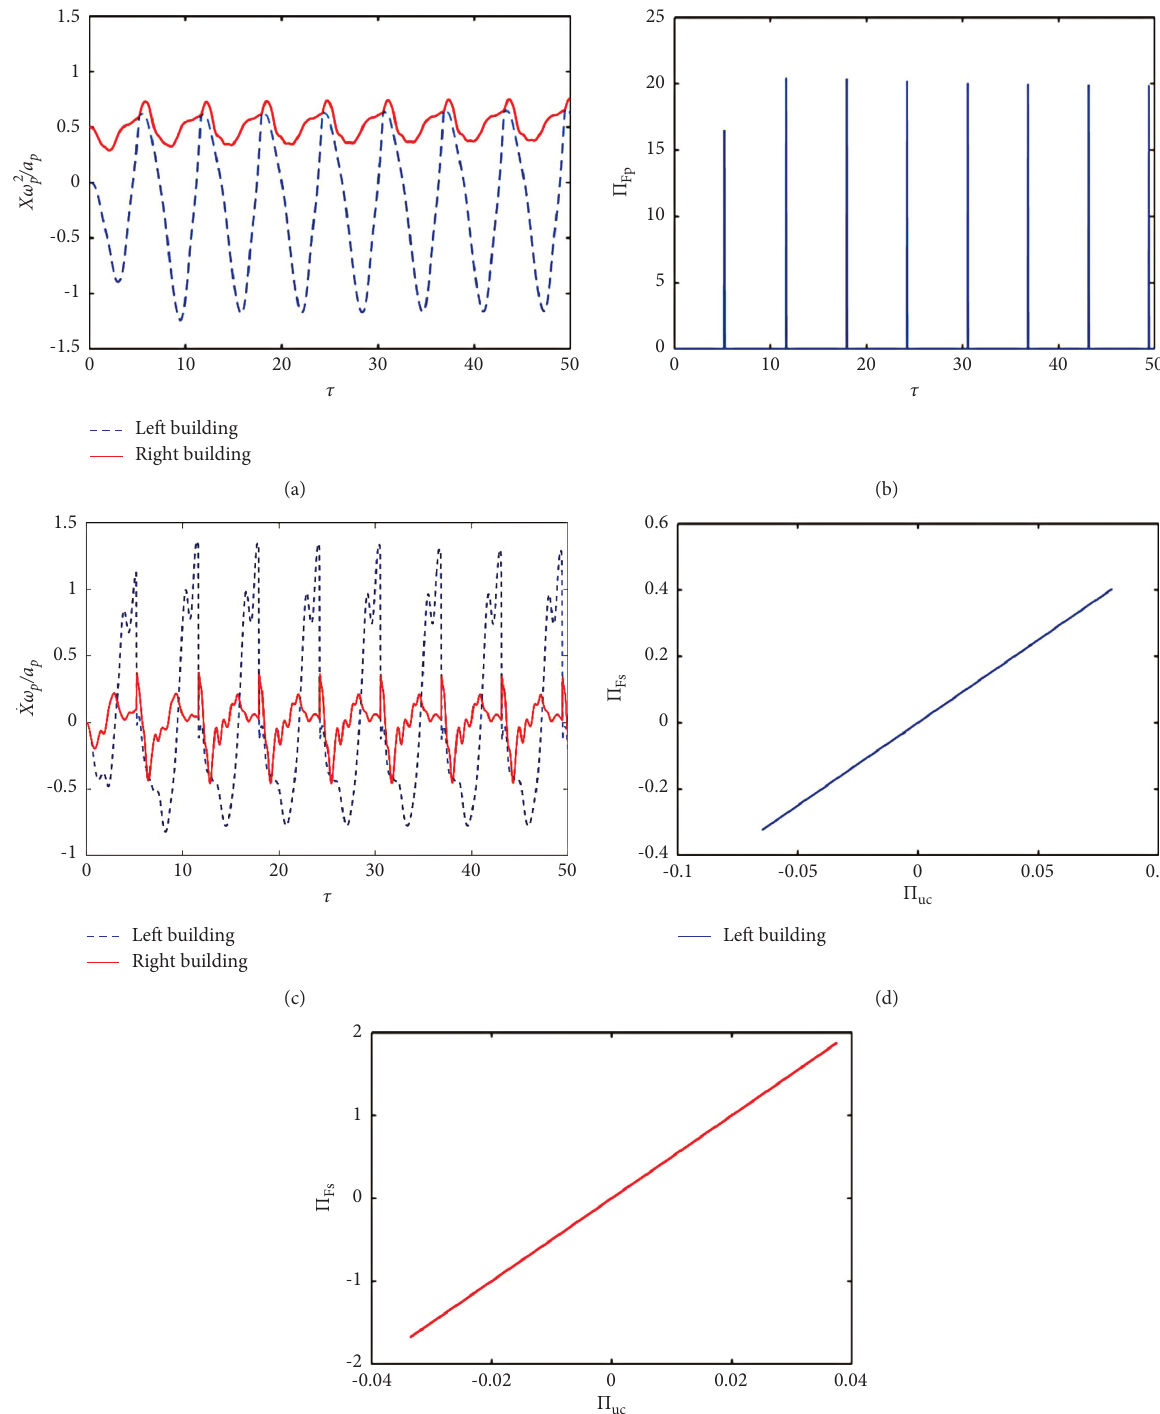
Figure 5: Displacement, velocity, pounding force histories, and hysteresis curves for the third story of adjacent buildings. (a) Displacement histories. (b) Pounding histories. (c) Velocity histories. (d) Hysteresis curve of the left structure. (e) Hysteresis curve of the right